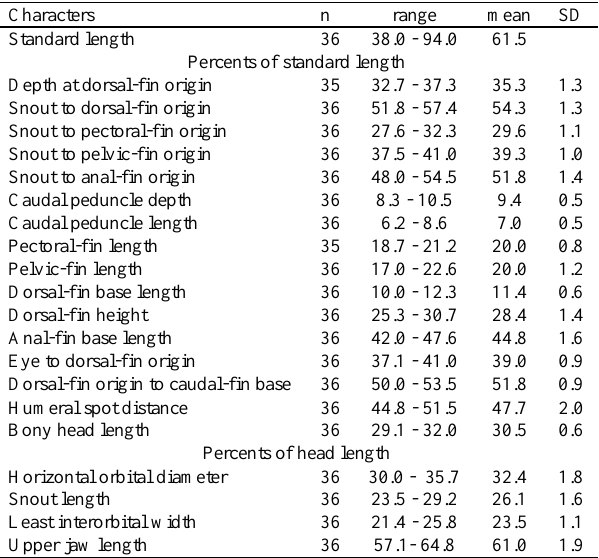
Table 15. Morphometrics of Charax tectifer . Specimens are from MZUSP 38709, MUSM38670, 37932, 38759. Characters Depth at dorsal-fin